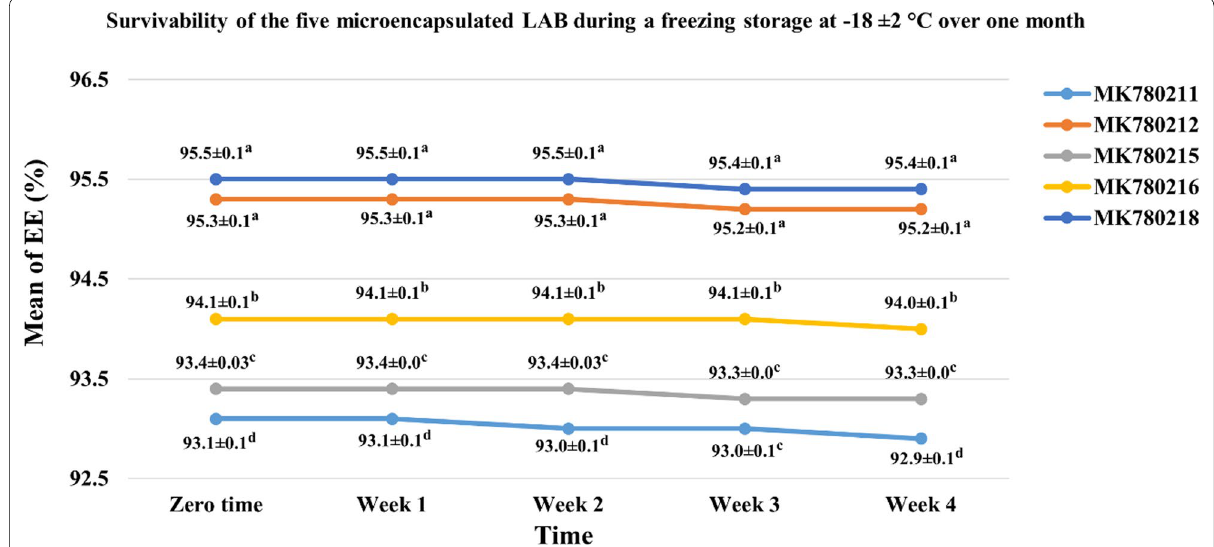
Fig. 6 Survivability of the five microencapsulated LAB during freezing storage at -18 during one month for each strain. Data were expressed as mean ( are not significantly different at sig. ( p